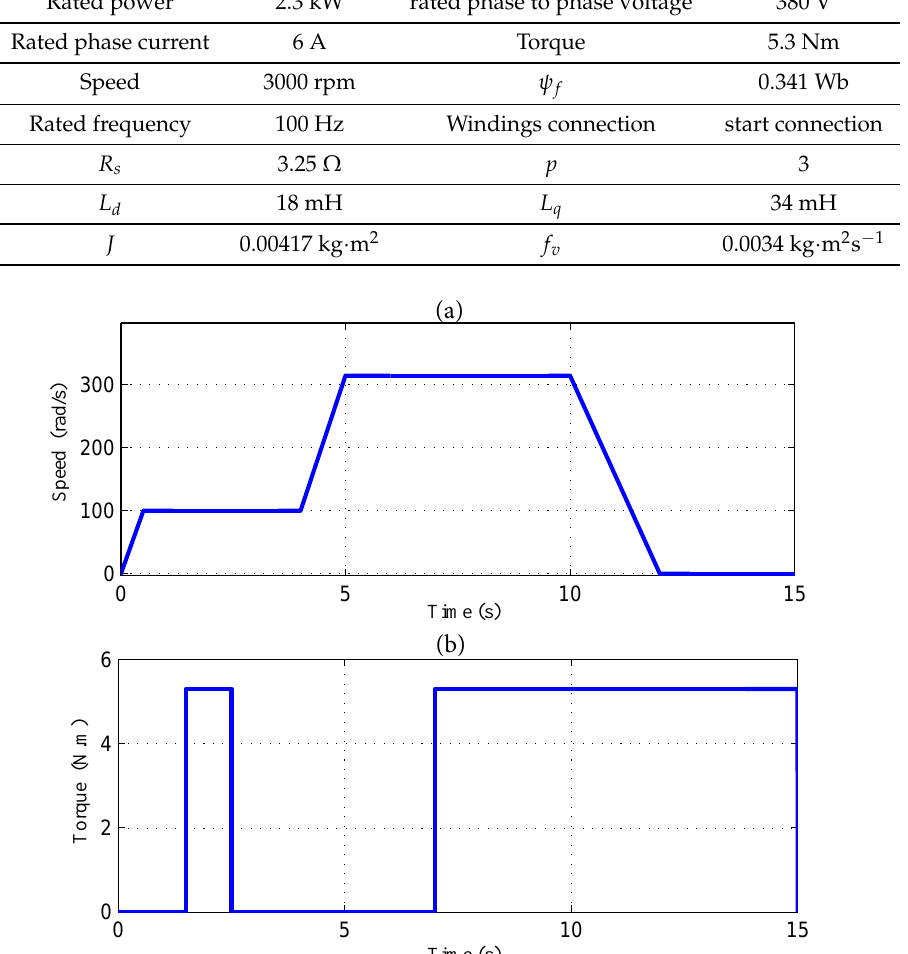
Figure 2. Industrial benchmark trajectory for: ( a ) speed; and ( b )